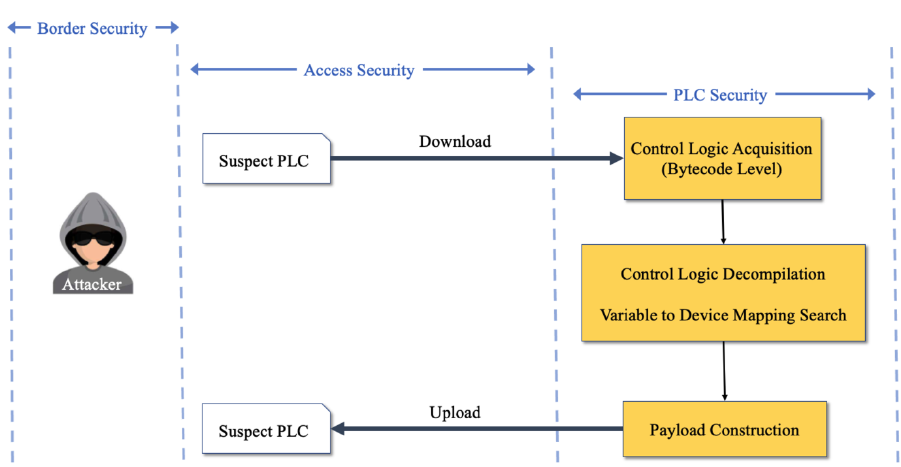
Figure 15. Different Defense Stages of